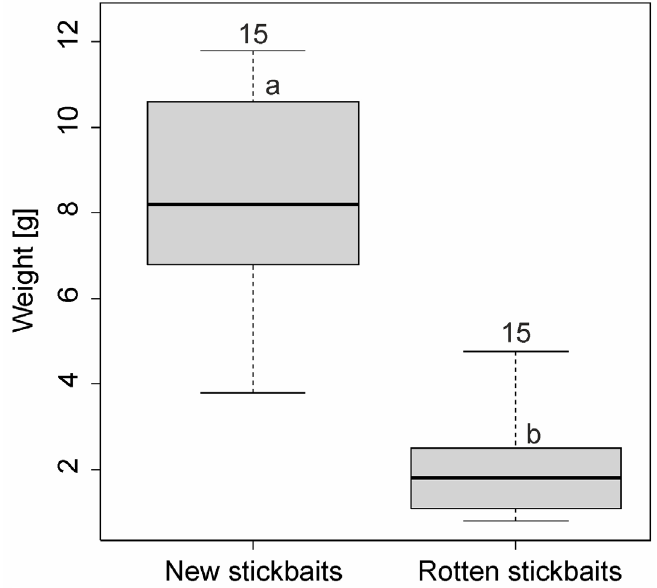
Figure 6. Box–whisker plot (25% quantile, median. 75% quantile, whisker: minimum and maximum values) of the weight proportion of a subset of the exact same makes and models of new and rotten shads and twisters. Note that only the soft plastic body of the items without lead head and hook were considered for this analysis. Letters above the median indicate significant differences between items. Numbers above the whisker indicate the number of items in the respective group.